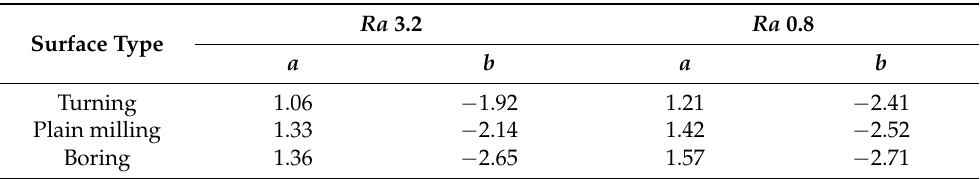
Table 4. Parameters of the lognormal distribution characterization model.